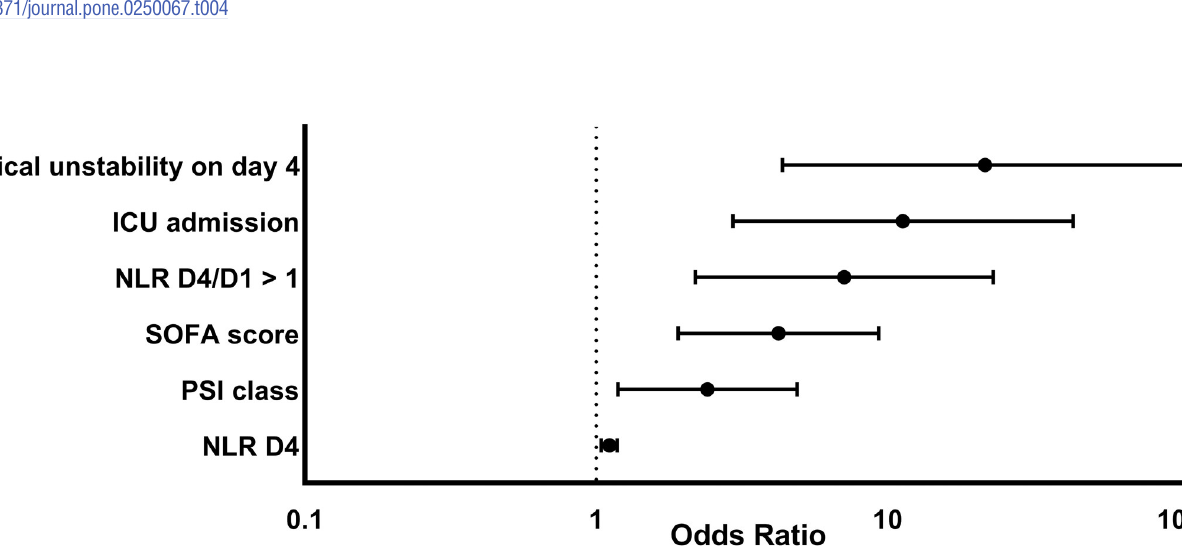
Fig 2. Odds ratios of several parameters to predict 30-day